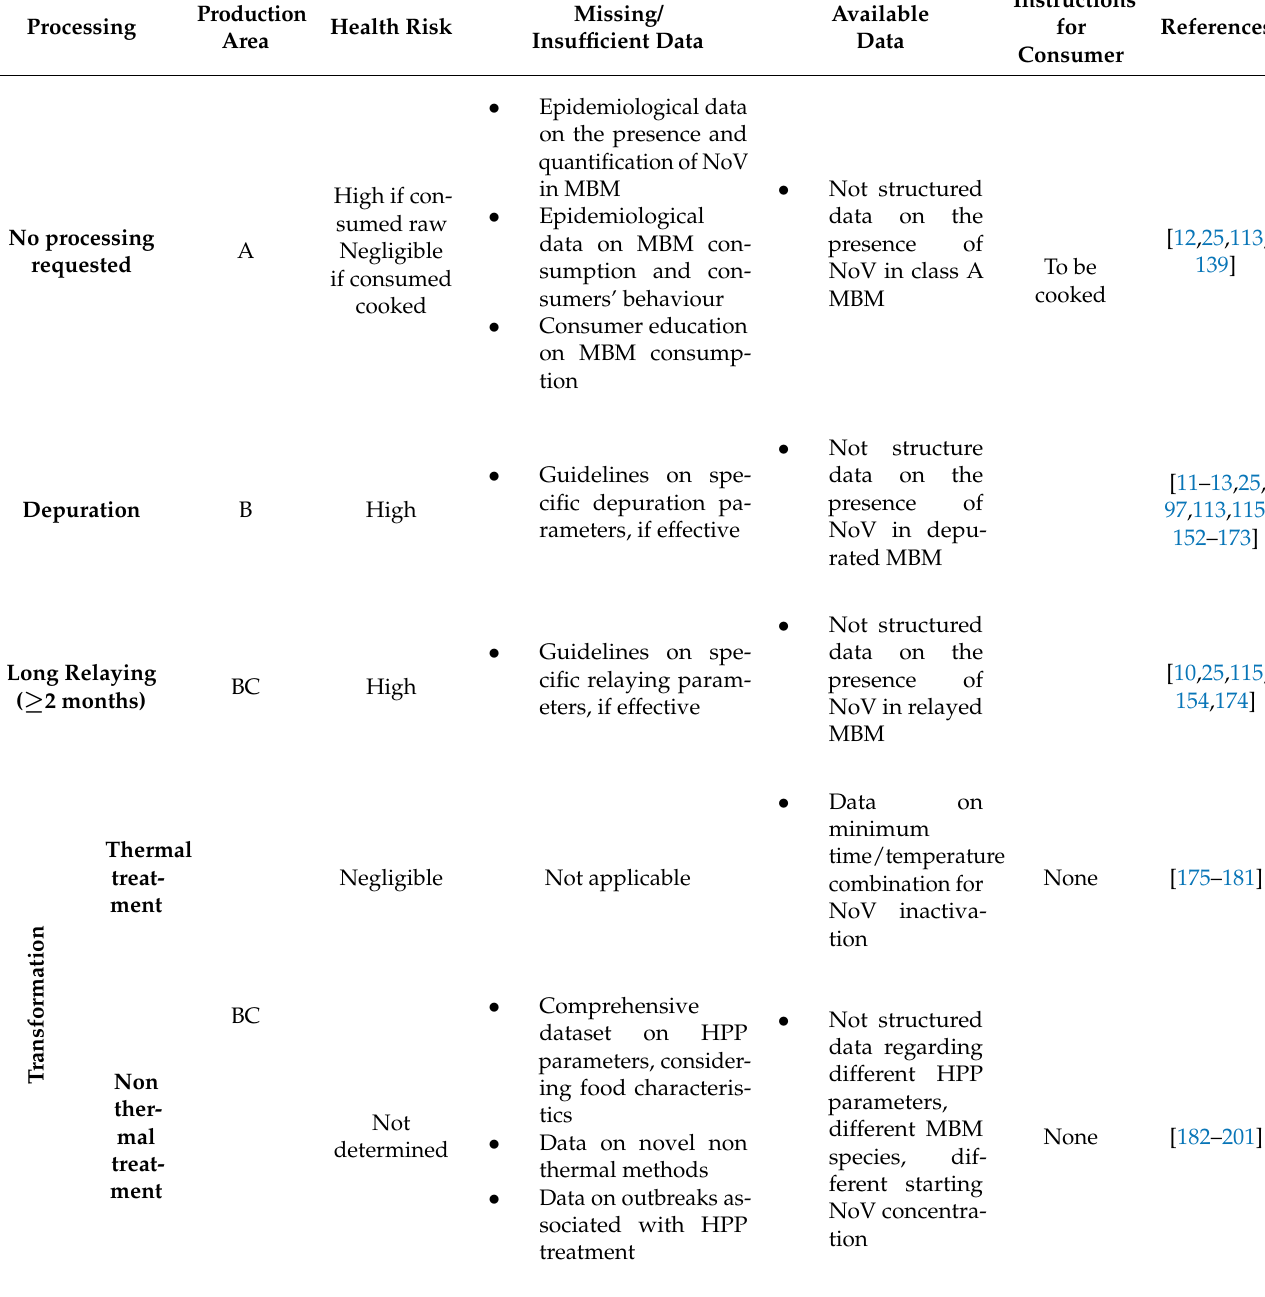
Table 1. Relationship between production area, processing, and health risk. MBM = marine bivalve molluscs.